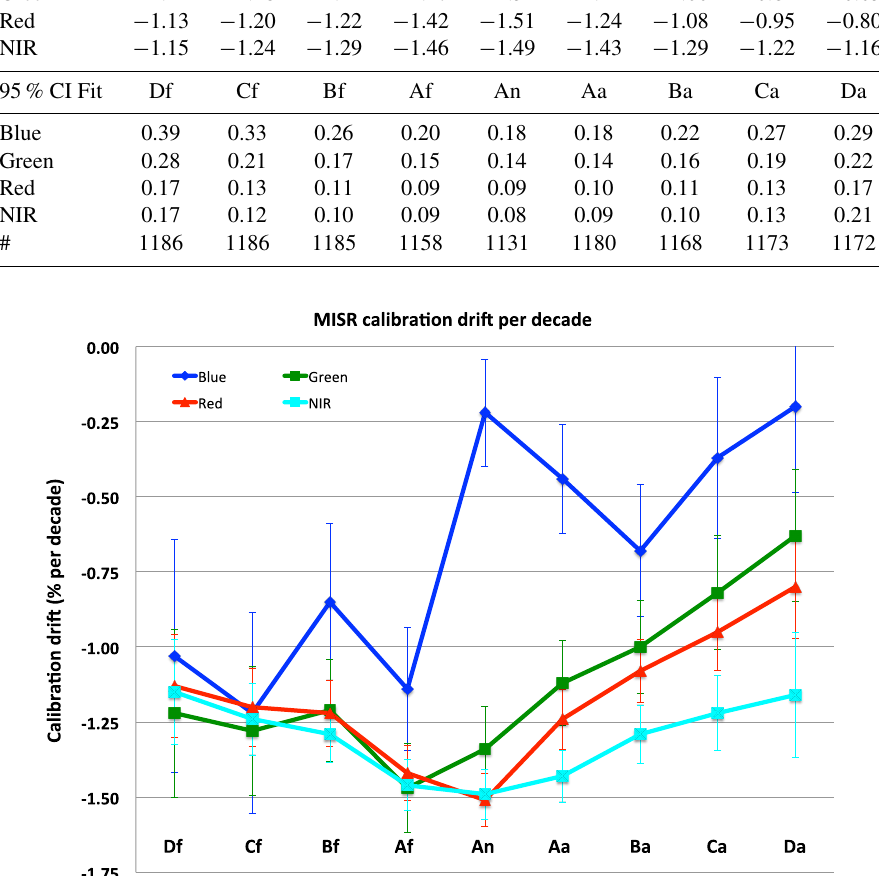
Figure A3. MISR calibration drift per decade (in percent) for all four wavelengths and nine cameras. The data used to generate this plot were aggregated from three pseudo-invariant desert sites (Libya-4, Libya-1, and Egypt-1). The mean decadal trends and the 95% confidence intervals (Student’s t -test) are plotted. The viewing angles associated with the MISR cameras are the following ( f is forward, a is aft): Df